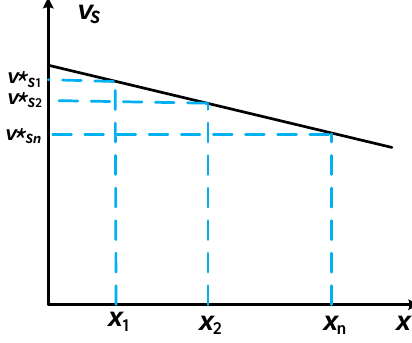
Figure 6. Droop characteristics for different node voltages.